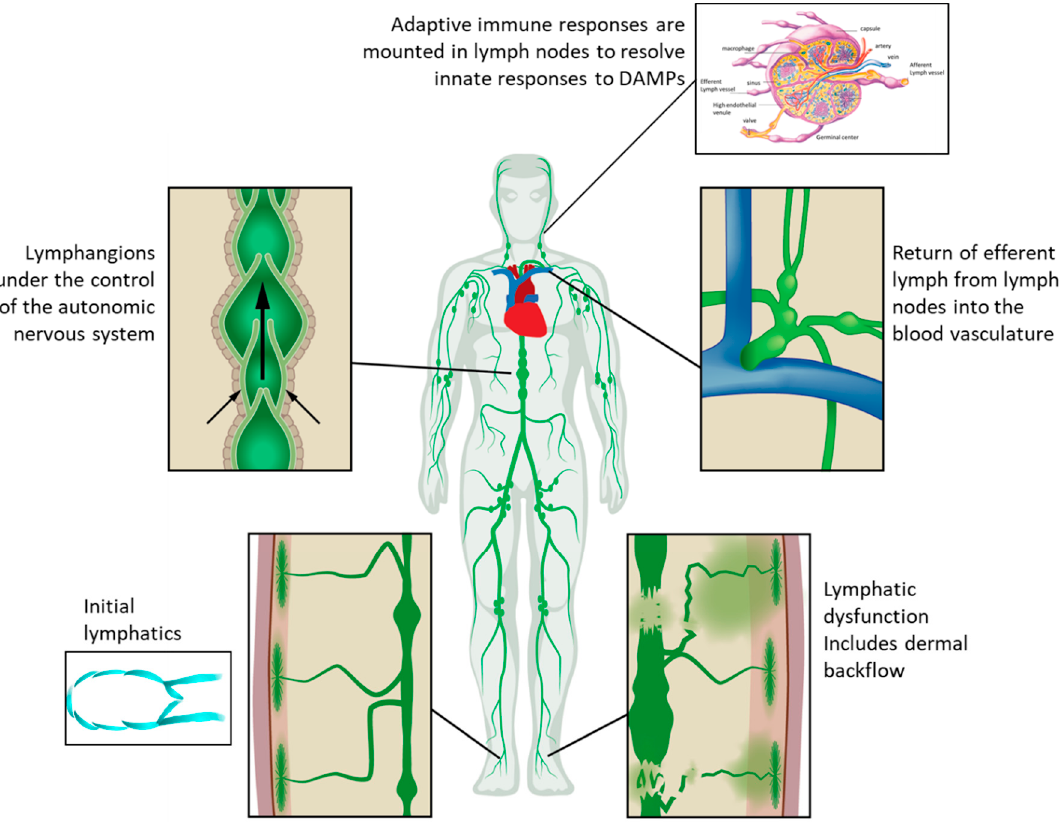
Figure 2. The open, unidirectional lymphatic system wherein entry into the lymphatics occurs at the initial lymphatics that lie beneath the epidermis and surround all internal organs. Once in the initial lymphatics, lymph is transited through collecting and conducting vessels through lymphangions and LNs before return to the subclavian vein (adapted from [10], O’Donnell, T.F., et al.